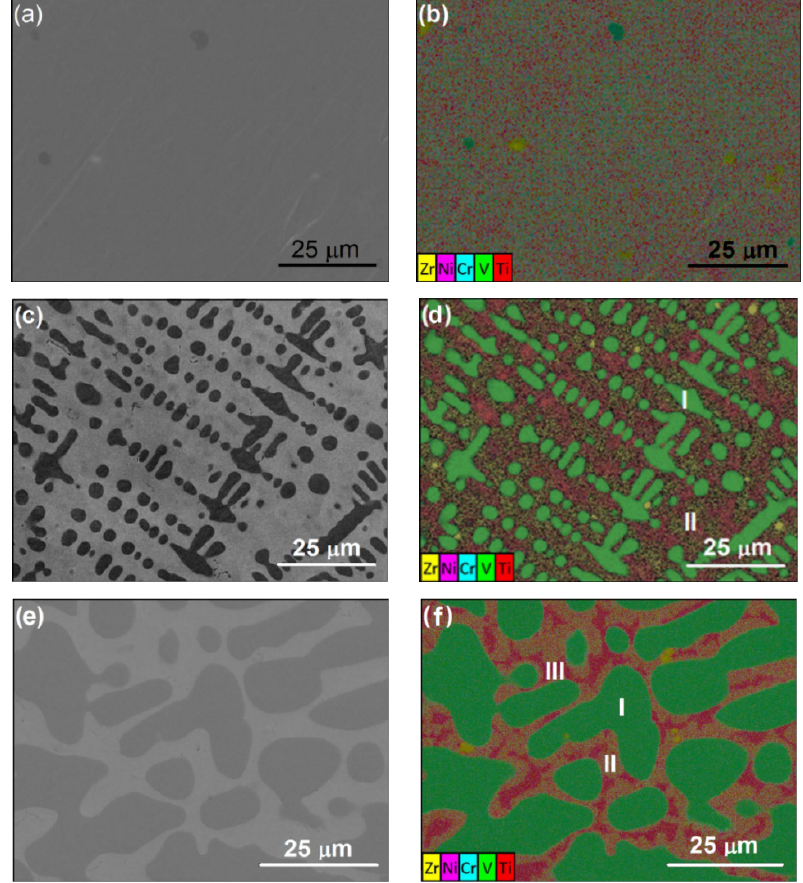
Figure 4. ( a , c , e ) Scanning electron microscopy (SEM) backscattered electron (BSE) images and ( b , d , f ) energy dispersive spectroscopy (EDS) mapping of Alloys ( a , b ) P1, ( c , d ) P3, and ( e , f ) P7, respectively. Phases I–III for P3 and P7 are shown in Table 2. Table 2. EDS results (in at%) from Alloys P3 and P7 showing phase segregation.